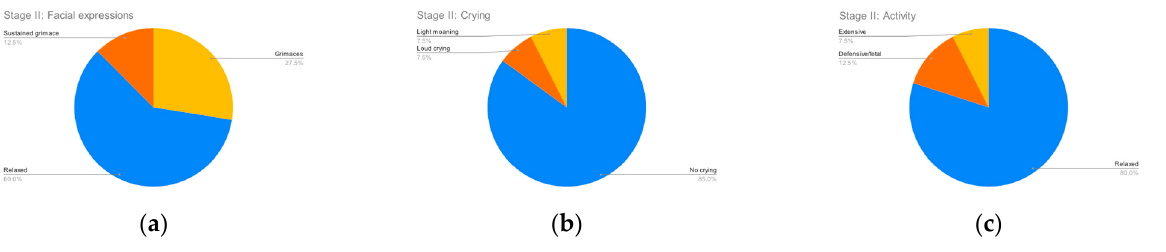
Figure 3. Stage II parameters. ( a ) Facial expressions; ( b ) Crying; ( c ) Activity.